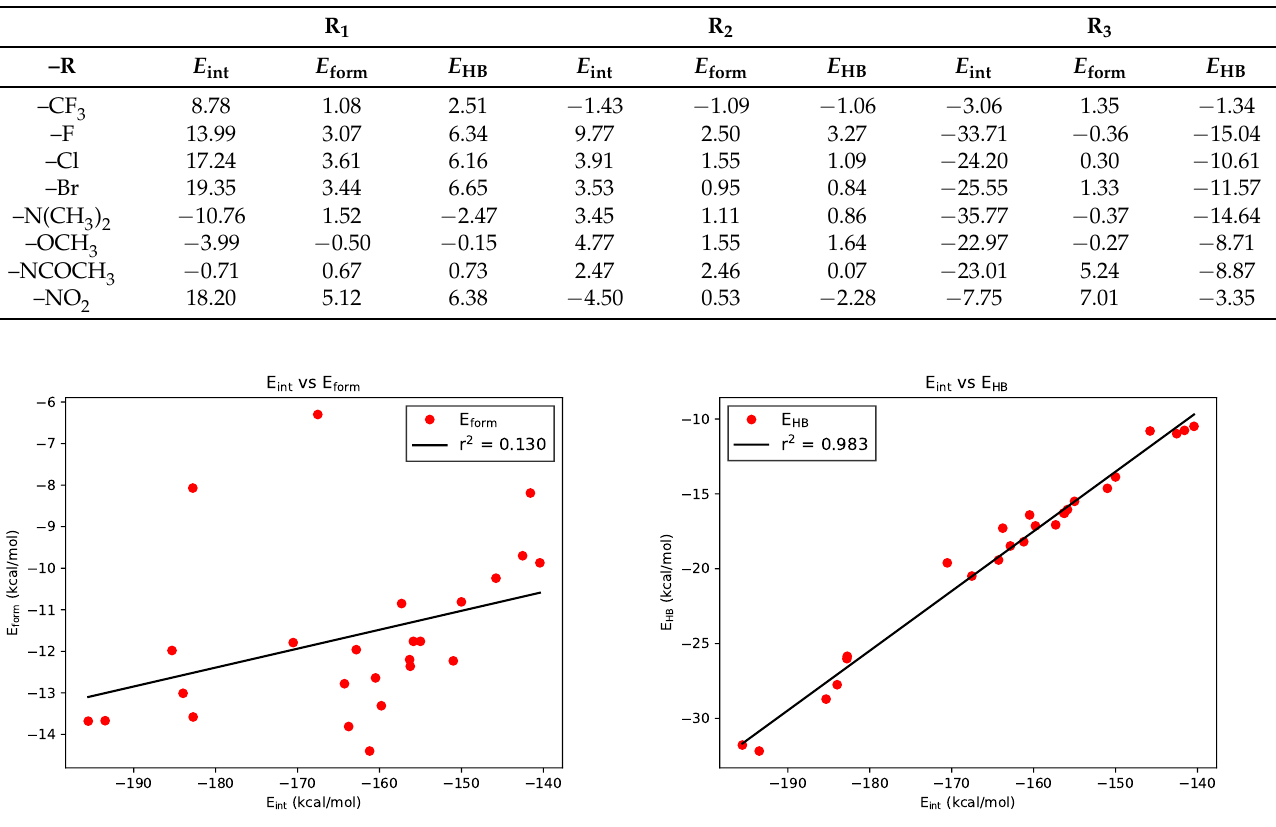
Figure 5. Correlation of IQA interaction energies with ( left ) OCM values of E form and ( right ) EM results of E HB